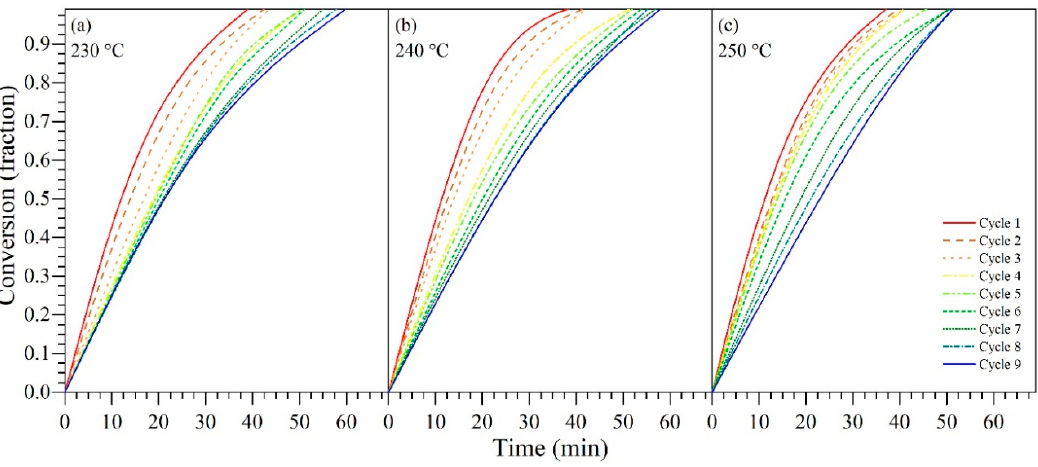
Figure 5. Isothermal conversion as a function of time at ( a ) 230°C, ( b ) 240°C, and ( c ) 250°C for n -C 7 asphaltenes in the absence and presence of CeNi0.89Pd1.1 through several catalyst regeneration cycles of adsorption and subsequent catalytic steam gasification. Nitrogen flow rate = 100 mL·min − 1 , H 2 O (g) flow rate = 6.30 mL·min − 1 , heating rate = 20°C·min − 1 , and asphaltene load of 0.2 mg·m − 2